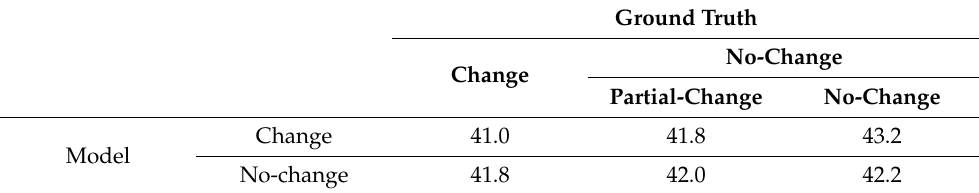
Table 9. The average percentage of cloud-free pixels in Set B by change